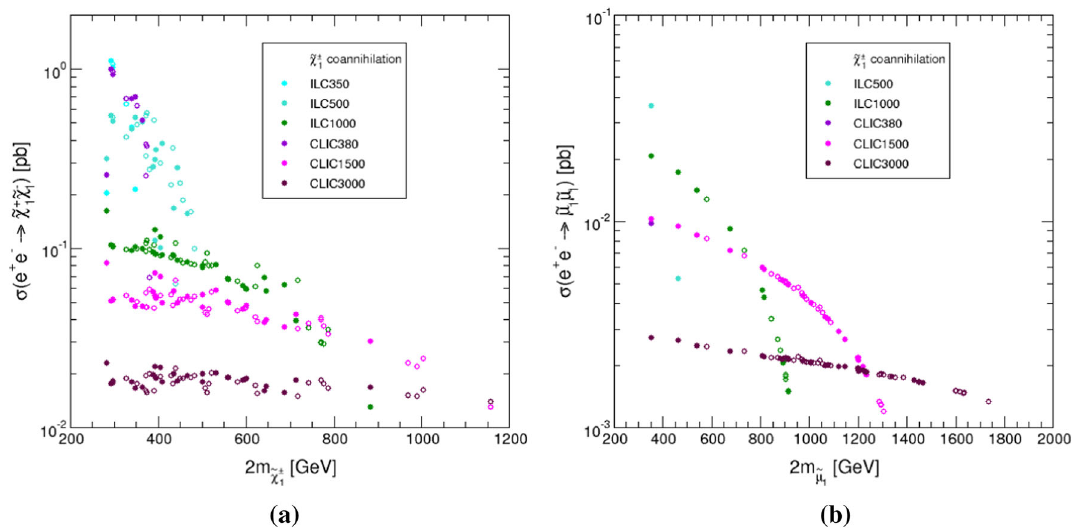
˜ χ ∓ (left) and e + e − → ˜ μ 1 ˜ μ 1 (right) in the ˜ χ ± 1 1